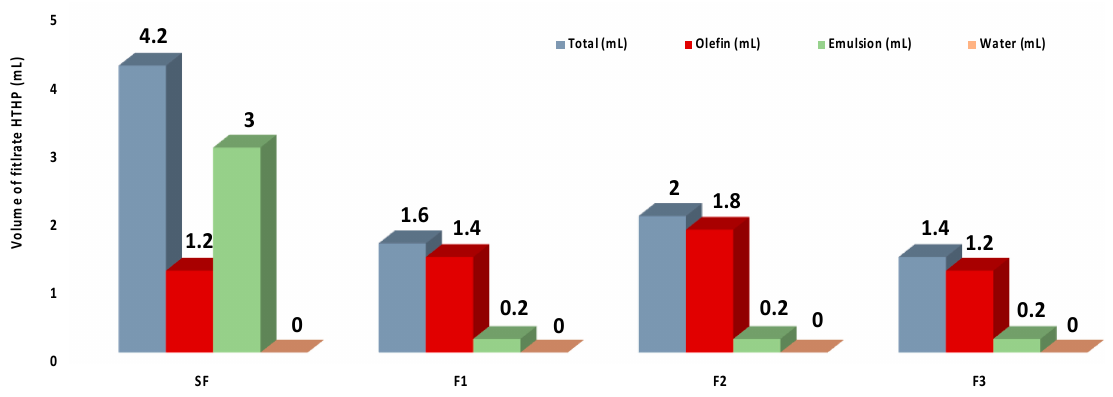
Figure 7. Volume of filtrate of the olefin-based drilling fluids after HTHP filtration. To obtain better insight into the filtration behavior of the drilling fluids, water-in-oil dispersions (water/olefin = 20/80 and brine/olefin = 40/60 and 20/80) containing CNC- g -PNIPAM2 were prepared in Ultra Turrax ® . The visual aspect of the systems is displayed at Figure 8. The CNC- g -PNIPAM2 formed an opaque dispersion immediately after stirring in olefin (Figure 8a), typical of certain affinity to the nonpolar medium, due to the presence of the -CH 2 -CHR- main chains from PNIPAM brushes. After adding distilled water, an outstanding gelled structure was formed (Figure 8b), suggesting polymer–water hydrogen bonding due to the amphiphilic character of PNIPAM. The literature states that filtration of a polymer-based fluid through a porous medium can be considerably reduced by increasing the elastic properties of the polymer [36]. The insertion of flexible PNIPAM chain grafts in the rigid structure of cellulose nanocrystals may produce the extensional viscosity needed to support the shear imposed during the filtration process at high pressure. In addition, a thin and elastic film (filter cake) of lower permeability also formed.